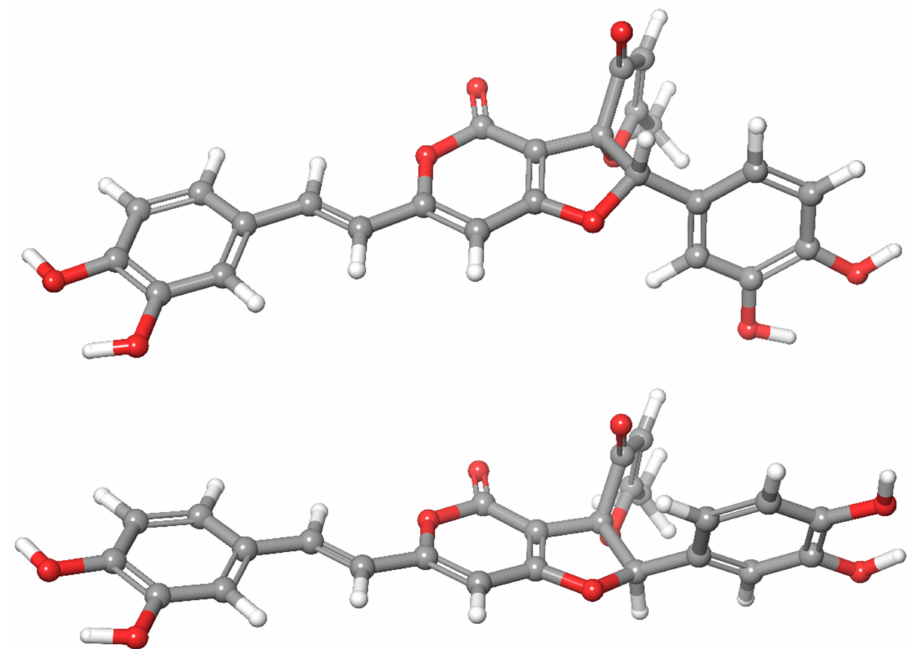
Figure 2. SS ( top ) and RS ( bottom ) epimers of inoscavin A (color scheme: grey: carbons, white: hydrogens, red: